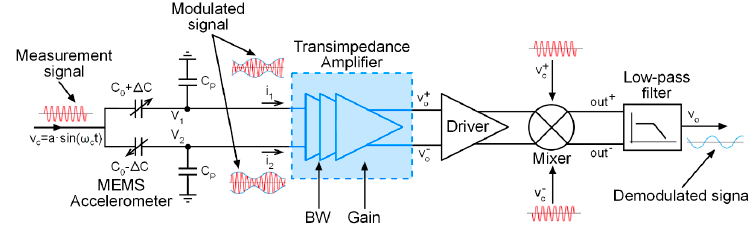
Figure 3. Conceptual scheme of the open loop synchronous demodulator.